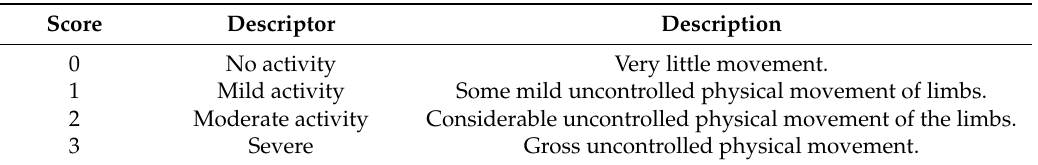
Table 1. Subjective scoring system used to assess post-stun/kill movement based on the level of spinal